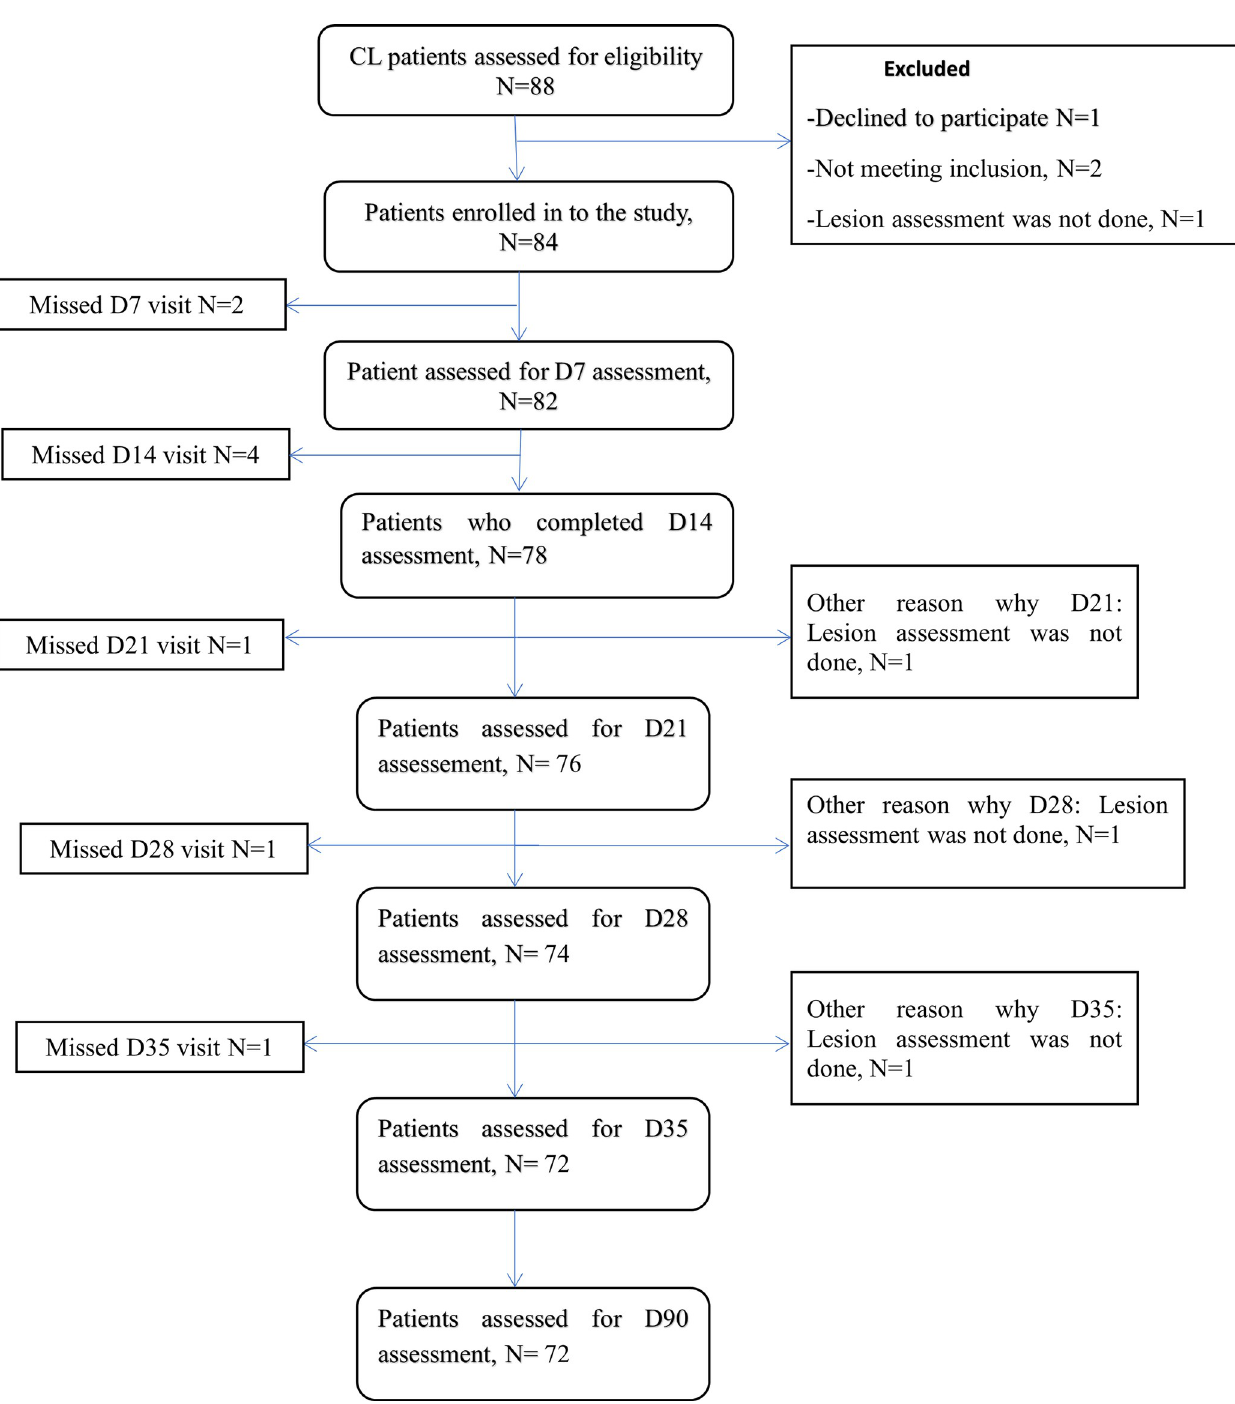
PLOS NeglectedTropical Diseases | https://doi.org/10.1371/journal.pntd.0010578 September 9,